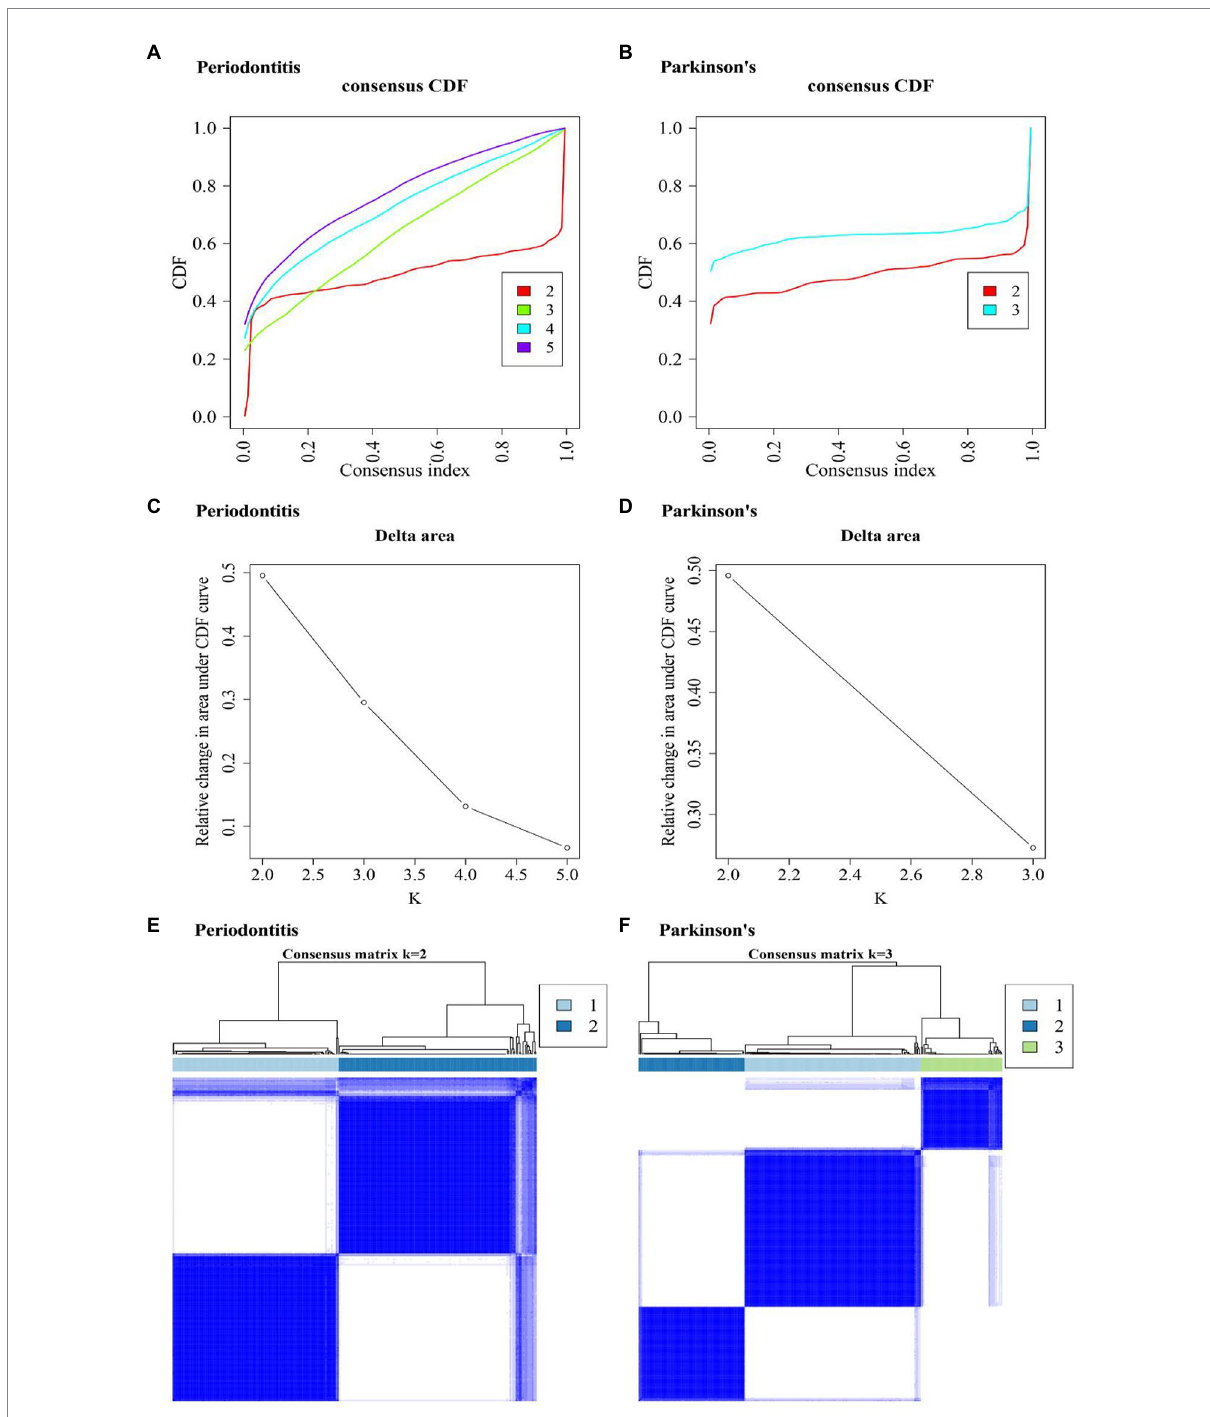
FIGURE 7 Consensus Cluster Plus analysis results. (A,B) Consistent cumulative distribution function (CDF) plot of periodontitis and Parkinson’s disease. This plot shows the cumulative distribution function of the score when k takes different values, which is used to determine when k is taken, CDF reaches an approximate maximum, and the cluster analysis results are the most reliable. That is, consider the k-value of the CDF descent slope is small. (C,D) The k and k-1 relative changes in area under the CDF curve in periodontitis and Parkinson’s disease. The total area under the CDF curve at k = 2 (the area below the line in (A,B) rather than the relative change in area). To select the final k-value, we should consider that the descending slope of the midline of (A,B) is as small as possible, and also consider that the relative change in the area under k and k-1 in (C,D) compared to the CDF curve is as small as possible. (E,F) Consistent cluster diagram of periodontitis and Parkinson’s